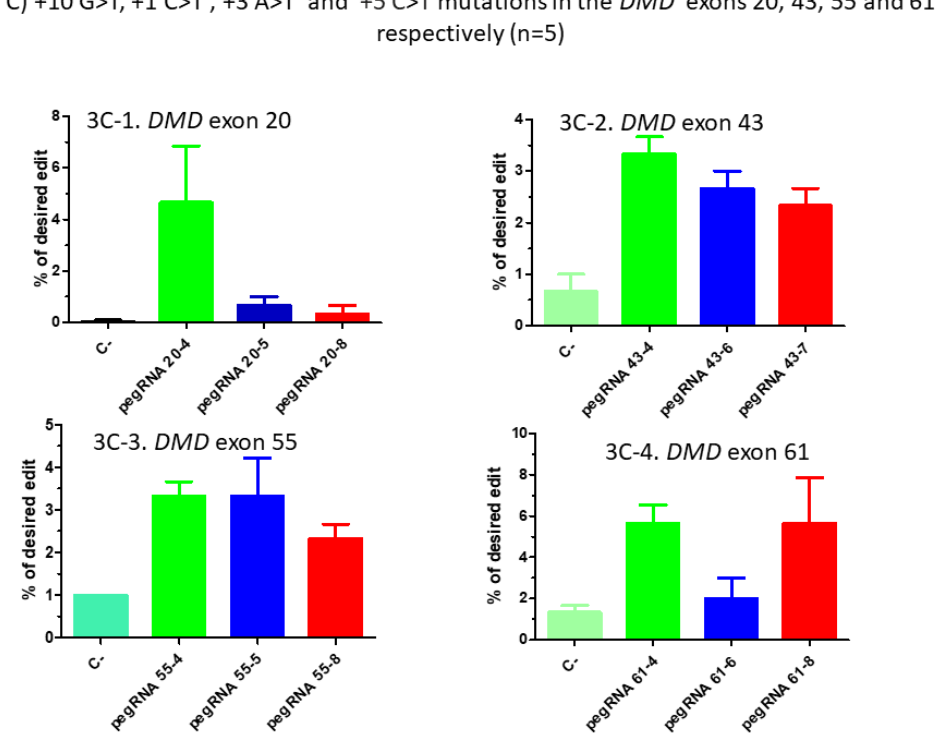
Figure 3. Prime editing of DMD exons 20, 43, 55 and 61. ( A ) Partial sequences of exons 20, 43, 55 and 61 of the DMD gene. The SpCas9n-RT PAMs are in a green box and the pegRNA protospacer sequences are underlined in red. The codons to be changed are in a blue box for each exon. ( B ) The sequences ( 5′ to 3′ ) of the Reverse Transcriptase Template (RTT, in blue) and of the Primer Binding Site (PBS, in green) of the three different pegRNAs targeting each of these exons of the DMD gene. The nucleotides in red colour in the RTT sequences represent the desired mutation to be introduced in the selected exons. ( C ) Results of Sanger sequencing and EditR analysis of prime editing of the DMD exons 20, 43, 55 and 61. For exon 20, there was 0% background level of thymidine (T) in the position of the targeted nucleotide. Results showed 4.5% of the desired edit with pegRNA20-4 and 1% with pegRNA20-5 and pegRNA20-8. For exon 43, there was a 1% background level of thymidine (T) in the position of the targeted nucleotide. The targeted modification showed 2.5% with pegRNA43-6 and pegRNA43-7 and 3.5% with pegRNA43-4. For exon 55, there was a 1% background level of thymidine (T) at the position of the desired edit. The targeted nucleotide showed 3.5% with pegRNA55-5 and pegRNA55-8 and 2.5% with pegRNA55-4. For exon 61, there was 1% background level of thymidine (T) in the targeted nucleotide position. The targeted modification showed 2% with pegRNA61-6 and 6% with pegRNA61-8 and pegRNA61-4. These experiments were carried out in five independent replicates ( n = 5).